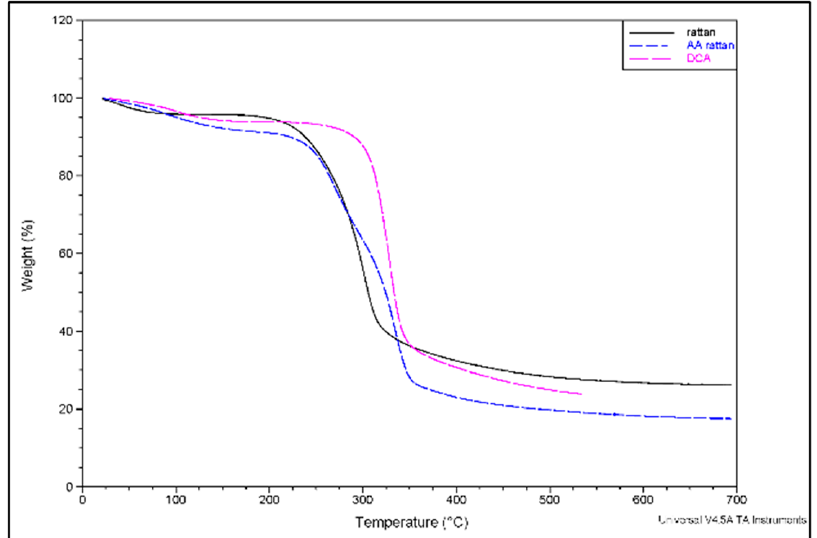
Figure 2. The TGA results of rattan (dark line), AA rattan (blue dashed line), and DCA (pink dashed line).